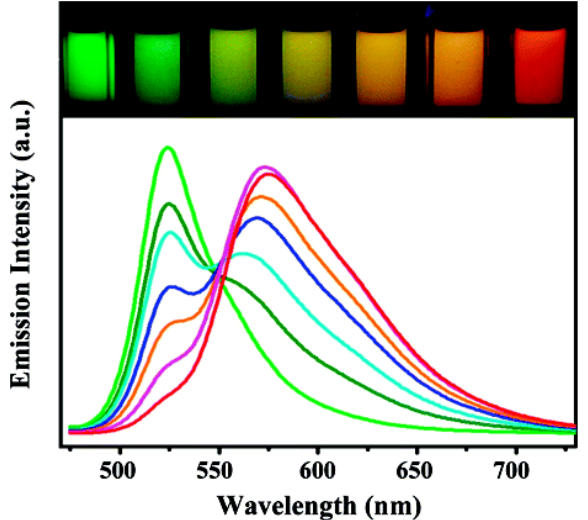
Fig. 2. (Top) Dispersions of FSNP under a 365 nm UV lamp. The amount of FITC was 0.06 mg, while those of Ru(phen) 2 þ were 0 mg, 0.0 mg, 0.02mg, 0.04 mg, 0.06 mg, 0.10mg, and 0.15mg, respectively (from left to right). (Bottom) emission spectra of the stepwise SNP. Reprinted with permission from Ref. 55 Copyright ° c 2010 American Chemical